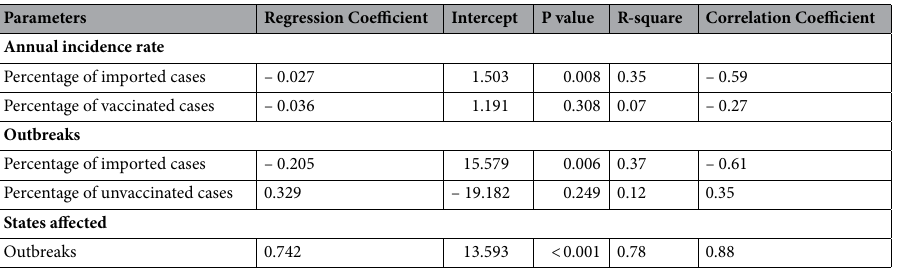
Table 3. Linear regression model for annual incidence rate in US residents, percentage of imported and vaccinated cases and outbreaks.